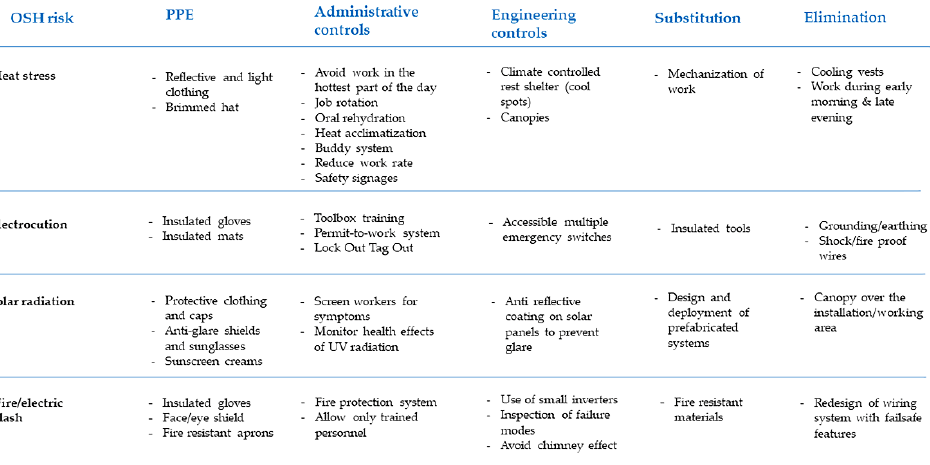
Figure 5. Hierarchy of controls to mitigate OSH risks under the high- and very high-risk categories (concepts/interventions not exhaustive).